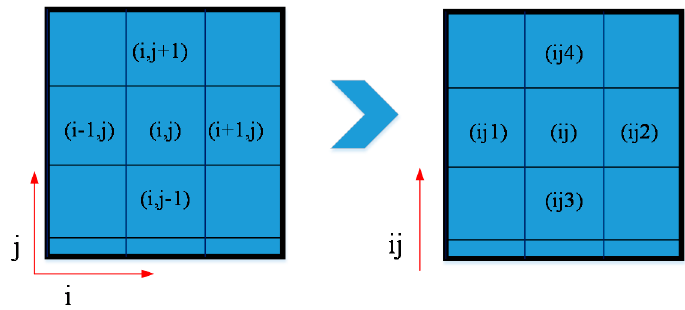
Figure 4. Neighboring relationship between ij with ij 1 , ij 2 , ij 3 , and ij 4 .